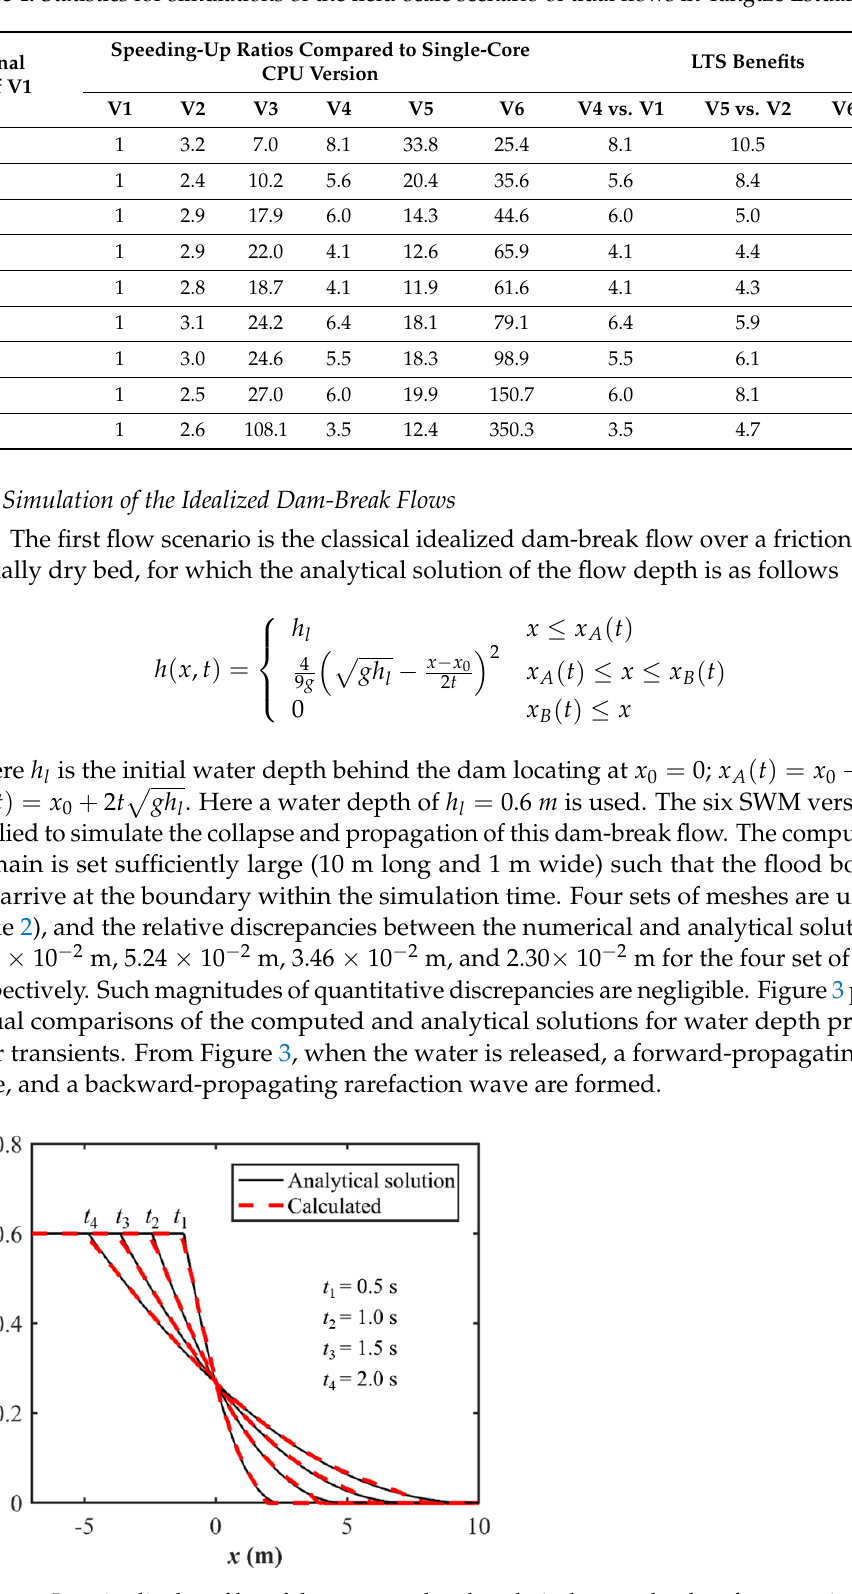
Figure 3. Longitudinal profiles of the computed and analytical water depth at four transients. Table 2 gives the mesh information (total number of cells, the mean equivalent length, the geometric standard deviation, and the gradient coefficient), computational cost of V1, the speeding-up ratios of V1-V6, and the LTS benefits. Figure 4 presents the varia- tion of the speeding-up ratios for V1-V6 against the total number of cells. From Table 2 and Figure 4, the computational efficiency of the six SWM can be roughly ranked as fol-